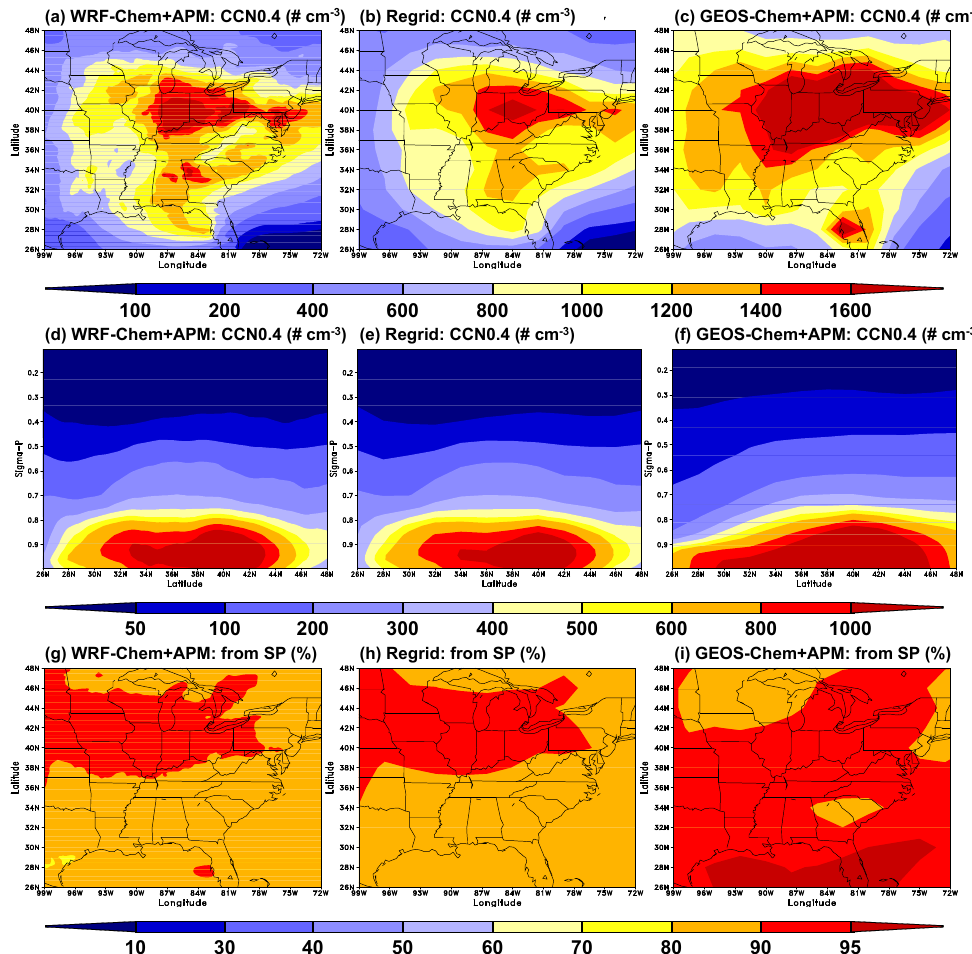
Fig. 6. (a, b, c) Simulated horizontal distributions of cloud condensation nuclei at water supersaturation ratio of 0.4% (CCN0.4) in the boundary layer ( ∼ 1km) by WRF-Chem+APM, WRF-Chem+APM regrided to the GEOS-Chem resolution, and GEOS-Chem+APM (2004 July); (d, e, f) simulated vertical profiles of CCN0.4 zonally averaged from 72 ◦ W to 99 ◦ W; (g, h, i) same as (a, b, c) , except for the fraction of CCN0.4 that is from secondary